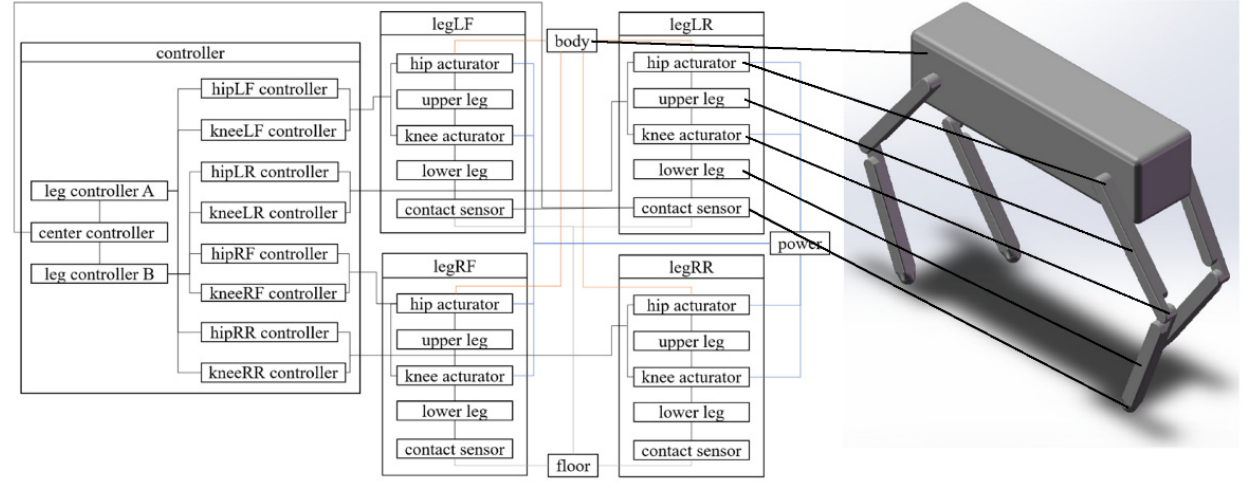
Figure 13. Logical architecture and preliminary structure of the quadruped robot.